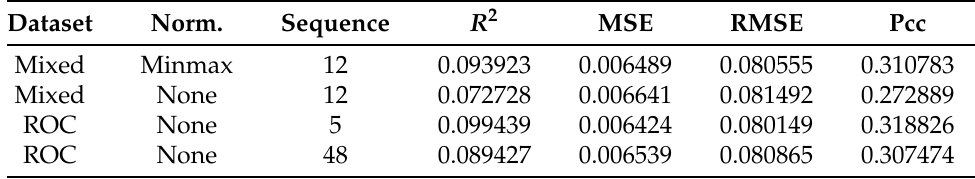
Table 7. Top 2 best metric performers in LSTM